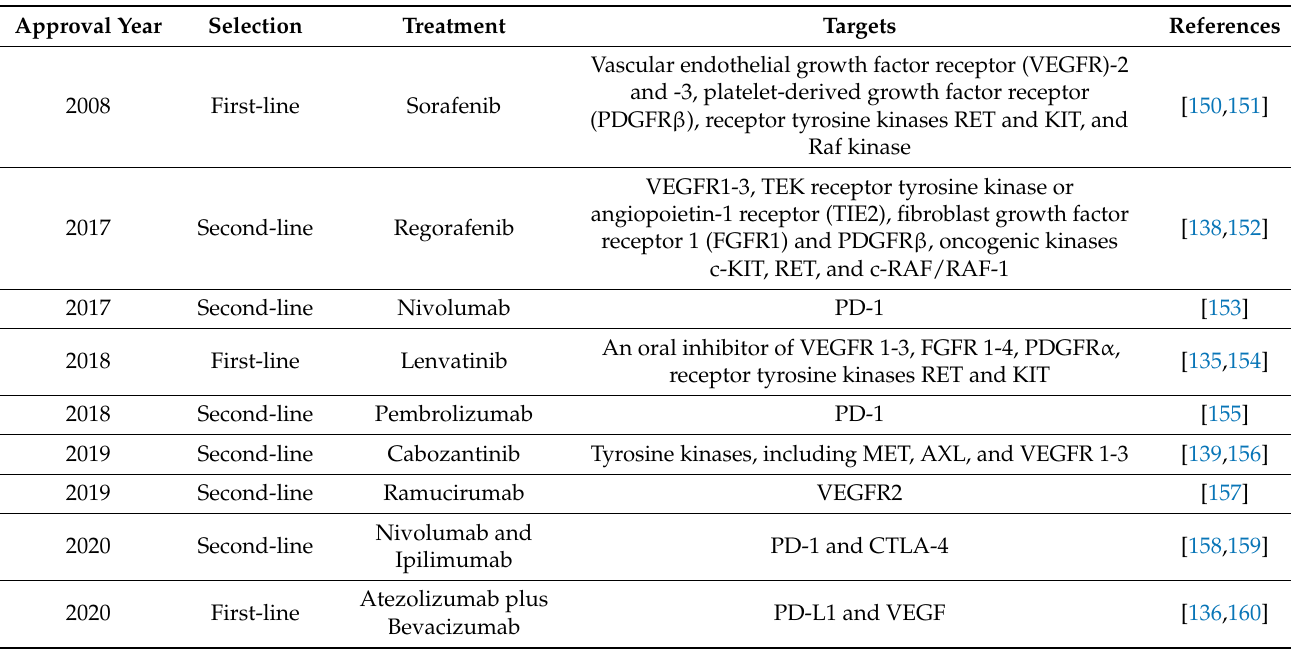
Table 2. FDA-approved treatments for